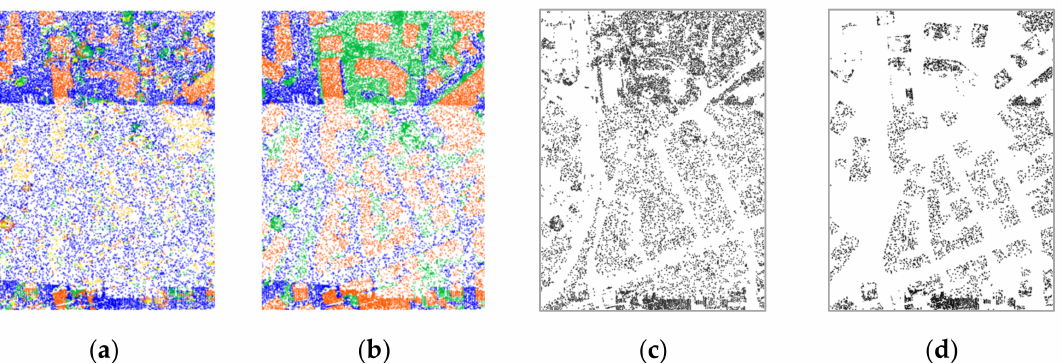
Figure 23. Results of semantic segmentation of new data 1 for Case 2: ( a ) prediction; ( b ) ground truth (i.e., label data); ( c ) difference between prediction and ground truth for all classes; ( d ) difference between prediction and ground truth for building class only.